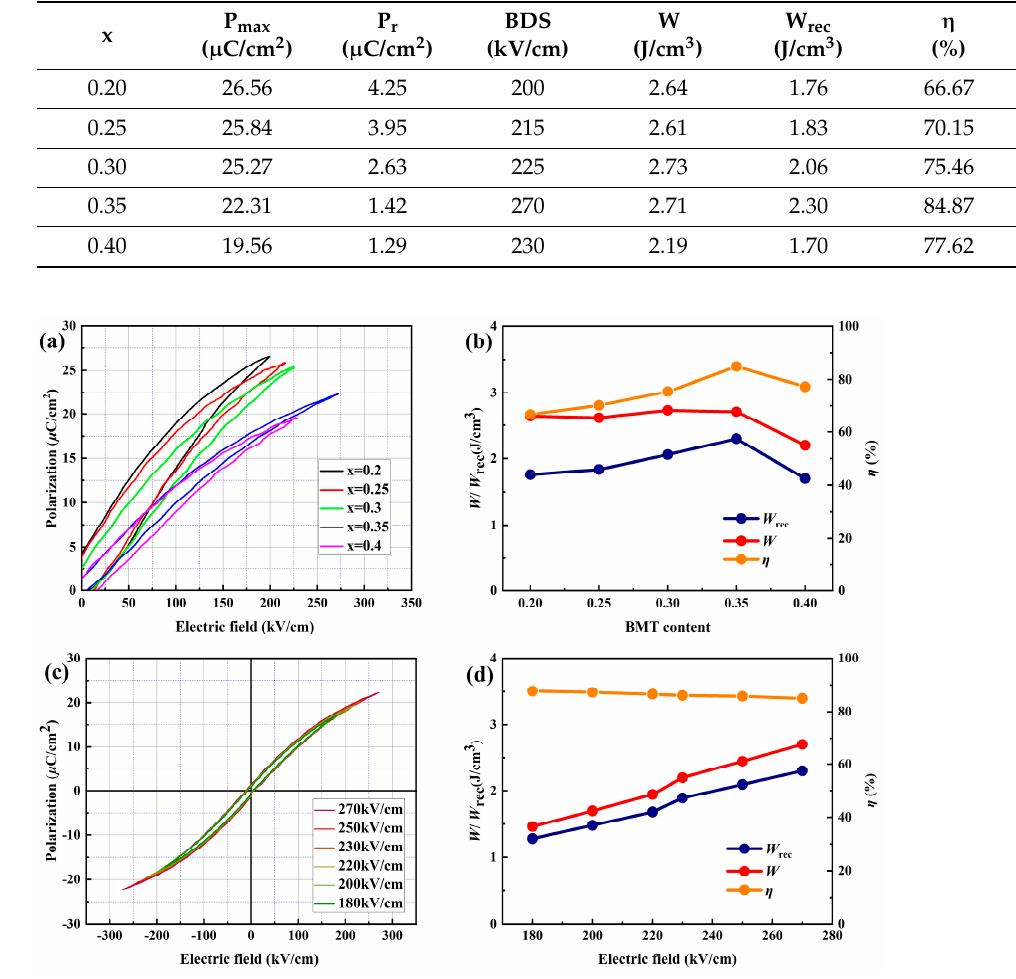
Figure 5. ( a ) P-E loops of (0.4 − x)BF-xBMT-0.6BT ceramics under series of electric fields; ( b ) computed ESPf of different compositions; P-E curves ( c ) and the computed ESPf ( d ) of 0.05BF-0.35BMT-0.6BT ceramics under different E at 10 Hz. Table 1. Energy storage properties of (0.4-x)BF-xBMT-0.6BT bulk ceramics at room temperature.